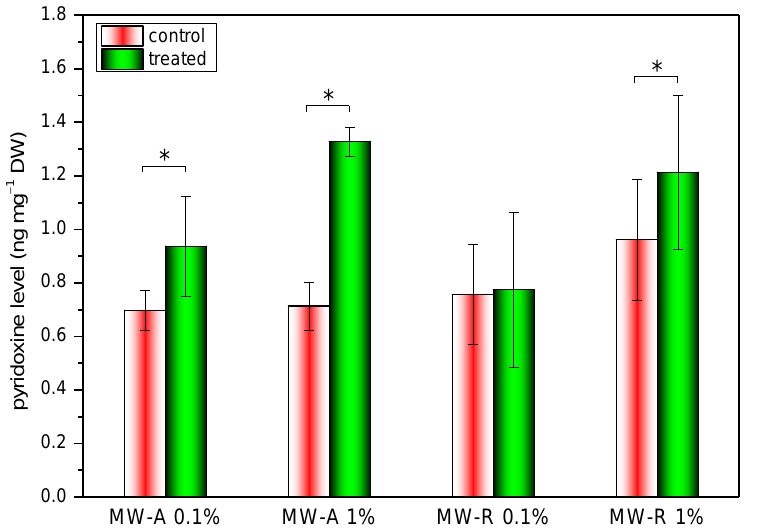
Figure 5. Comparison of the pyridoxine level in the control and TiO 2 NCs-treated leaf parts. * significant difference compared to control ( p ≤ 0.05).